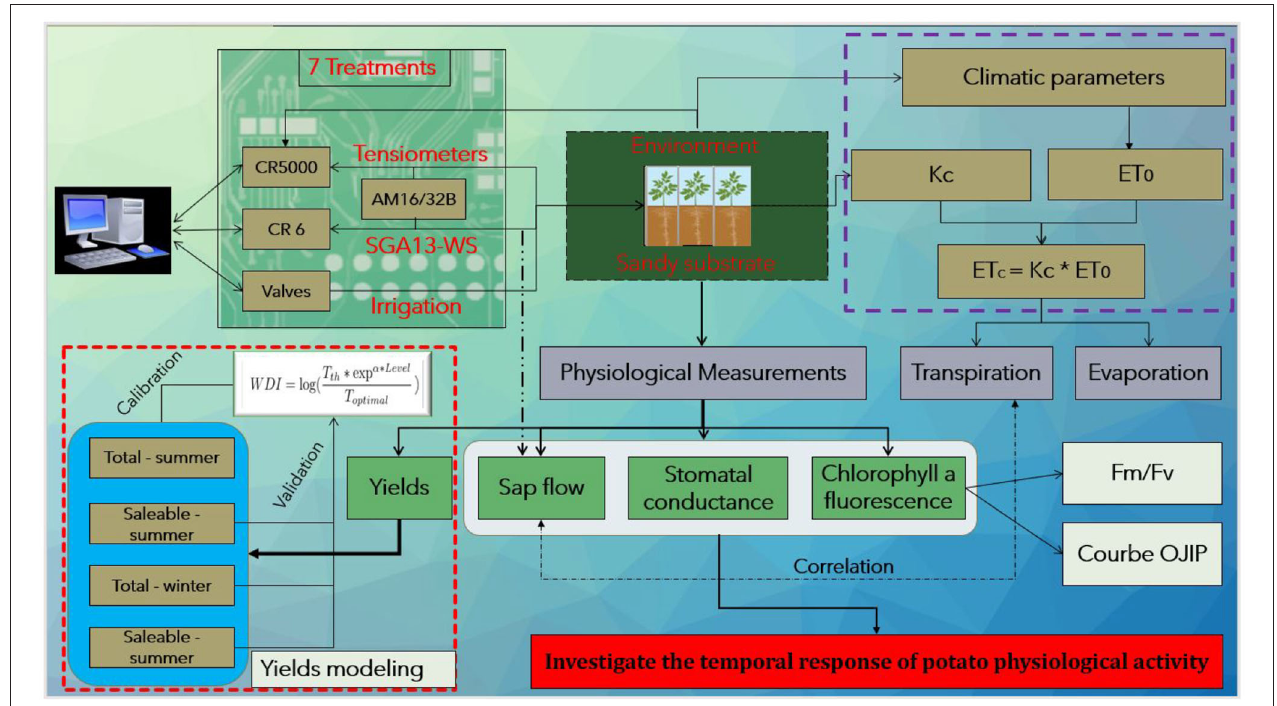
FIGURE 1 | Summary of the methodology applied in the